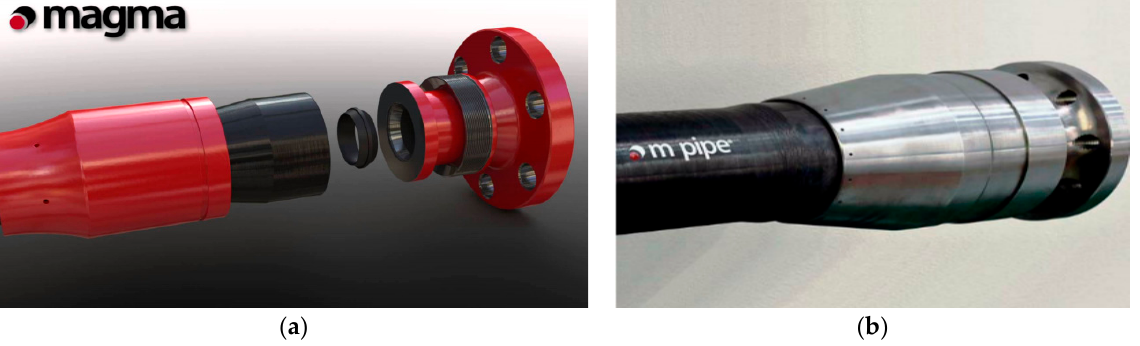
Figure 1. Composite riser pipe section with Magma m-pipe end fittings, showing ( a ) end-fitting with fittings, pipe, seal and smaller flange ( b ) end-fitting coupled with pipe and bigger flange with unique bolt ends (courtesy: Technip FMC’s Magma Global).